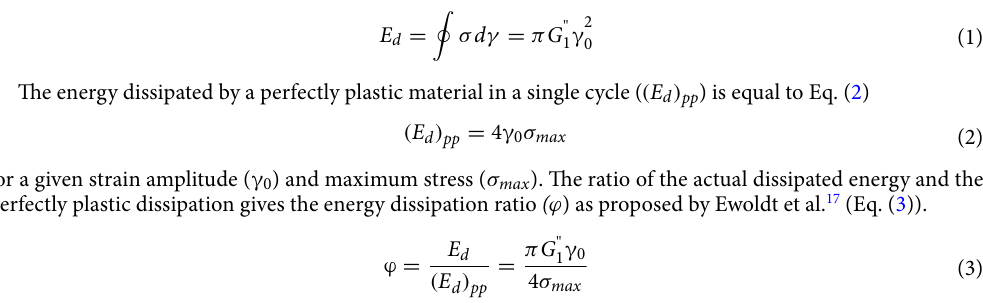
Figure 1. The storage modulus ( G and the end of the linear viscoelastic (LVE) regime 16